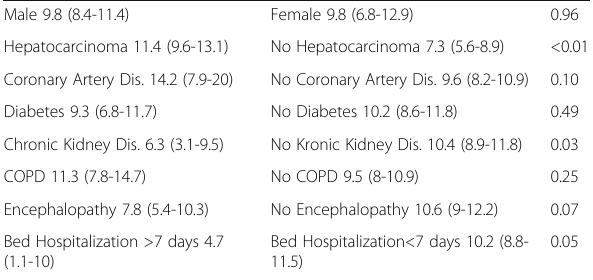
Table 1 (abstract 0045). Association of Vitamin D levels with baseline covariates